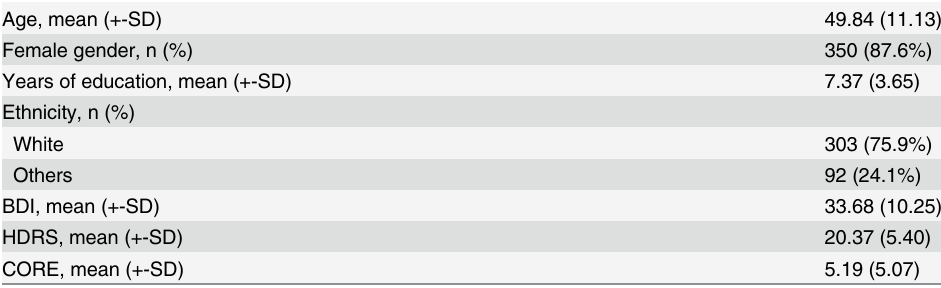
Table 1. Socio-demographic and clinical characteristics of the sample (n = 399).